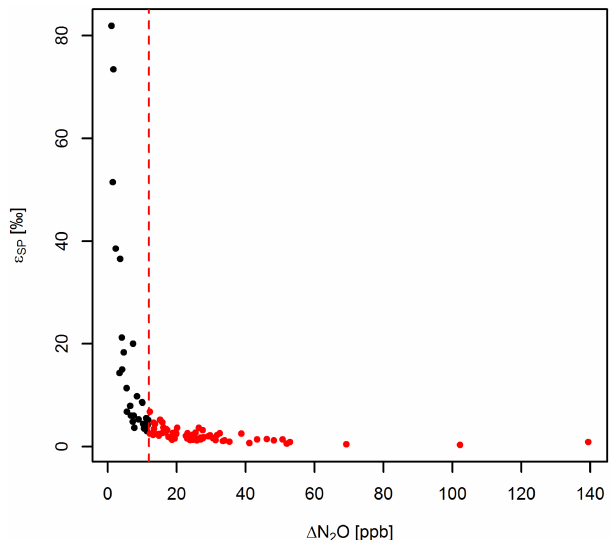
Figure 4. Standard error for SP ( ε SP ) of soil-derived N 2 O estimated by the Keeling plot approach as function of overnight N 2 O accu- mulation in the surface layer. The red dashed line shows 12ppb in- crease in N 2 O mole fractions. Red dots represent the selected sub- set.